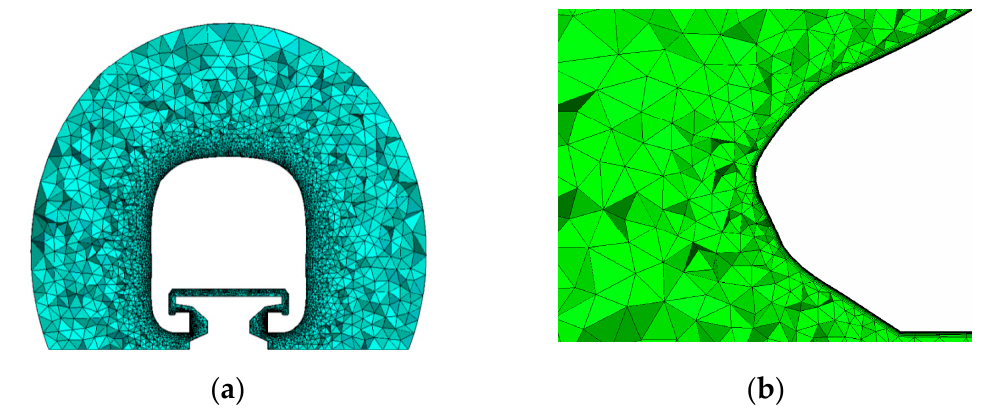
Figure 3. Computational mesh: ( a ) Cross-section mesh, ( b ) boundary layer mesh. The steady flow field is computed firstly, then the unsteady flow field is